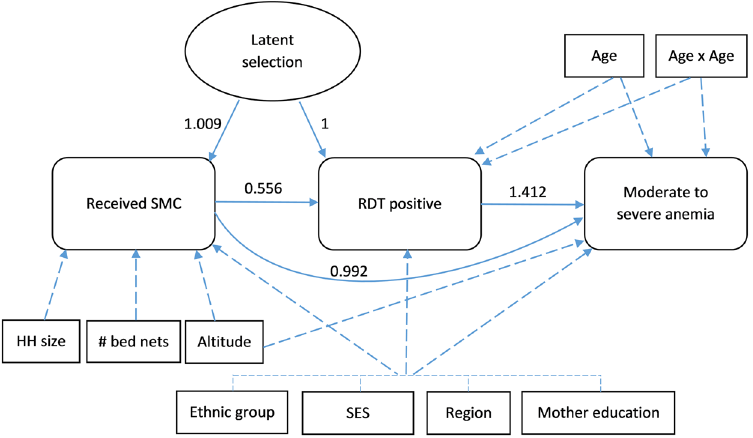
Figure 1. Flow chart of the SMC direct effects on RDT-confirmed malaria and the SMC indirect effects on moderate-to-severe anemia. Effect estimates were obtained by fitting a generalized structural equation model. Solid dashes link the outcomes and the latent variable between them. Long dashes link covariates to the outcomes. SES socioeconomic status; HH household; RDT rapid diagnostic test; SMC seasonal malaria chemoprevention;